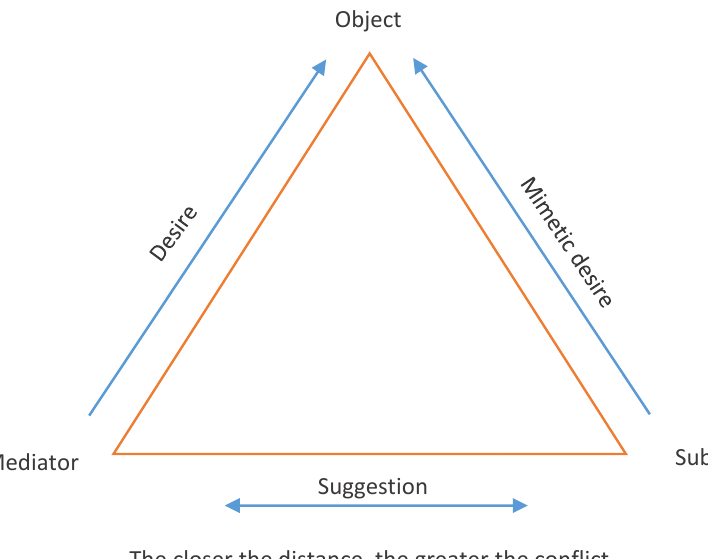
Figure 2. Triangle of the mimetic desire